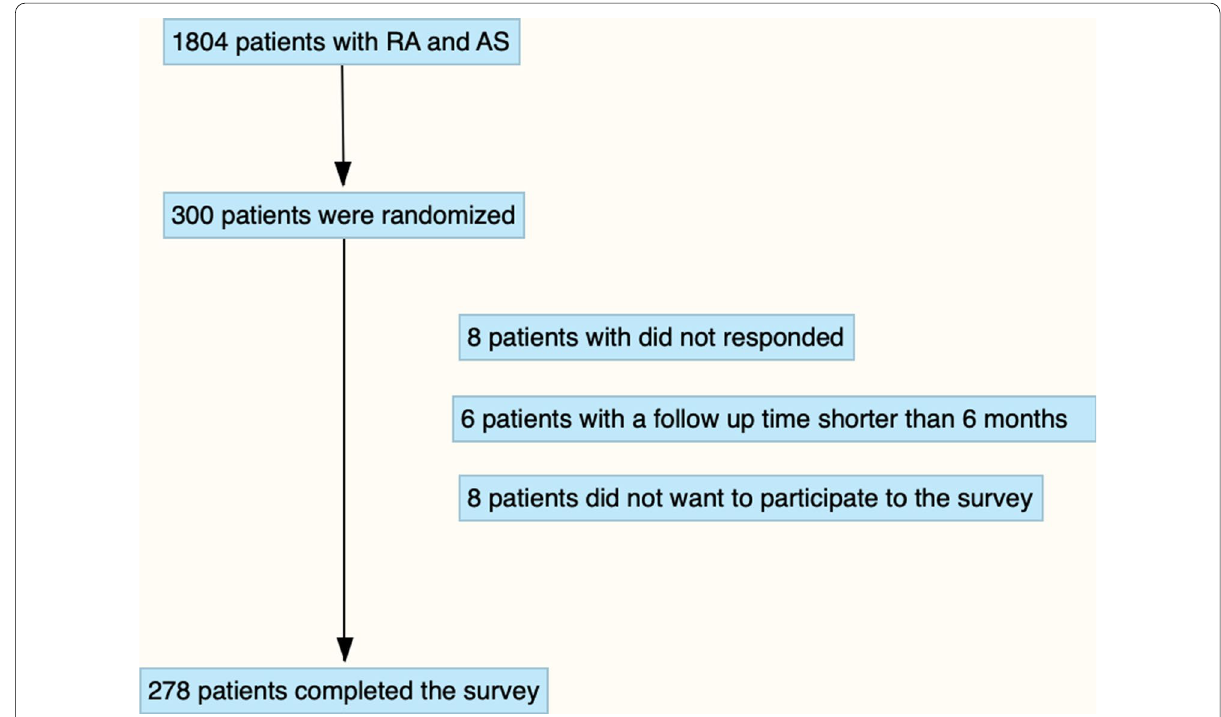
Fig. 1 Flowchart of the planning strategy of the